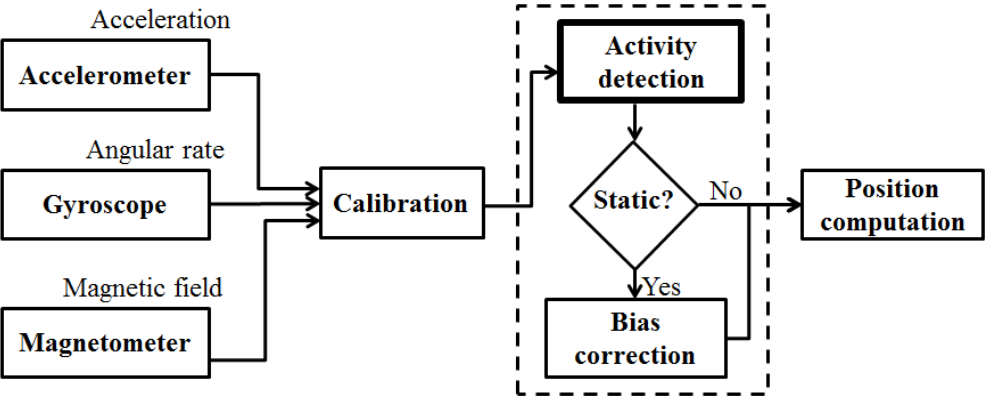
Figure 1. General diagram of positioning angles computation system based on inertial sensors. (In)activity detection is applied before position computation to allow correction of drifting